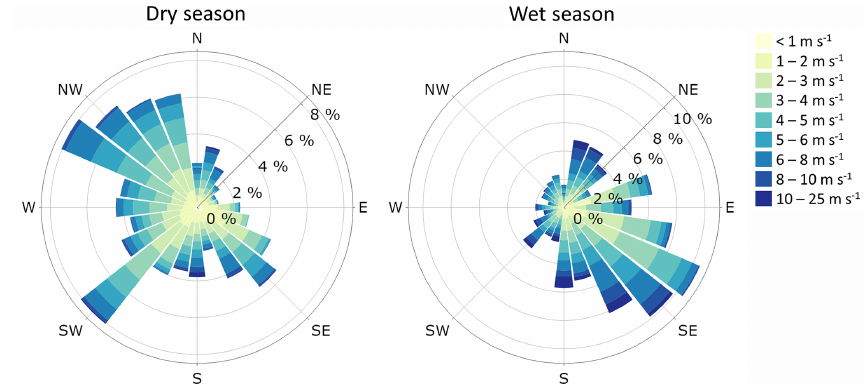
Figure 4. Average hourly wind speeds and wind directions during the dry (May–September) and the wet (October–April) meteorological seasons. The frequency of occurrence is indicated in percent of time for the entire measurement record of Hecate station (October 2015– October 2019). Table 3. Annual variability in precipitation, runoff, maximum snow depth, and mean air temperature (by water year; 1 October–30 Septem- ber). Runoff was averaged over all seven watersheds and scaled by watershed area. Precipitation and air temperature were averaged over all meteorological stations, except for Reference Station (no data 2015–2016). The period 2014–2015 was not calculated because stations WSN6226 and WSN844 had not been installed yet. Maximum snow depth was determined from daily aggregated values of 3h moving averages. NA represents not